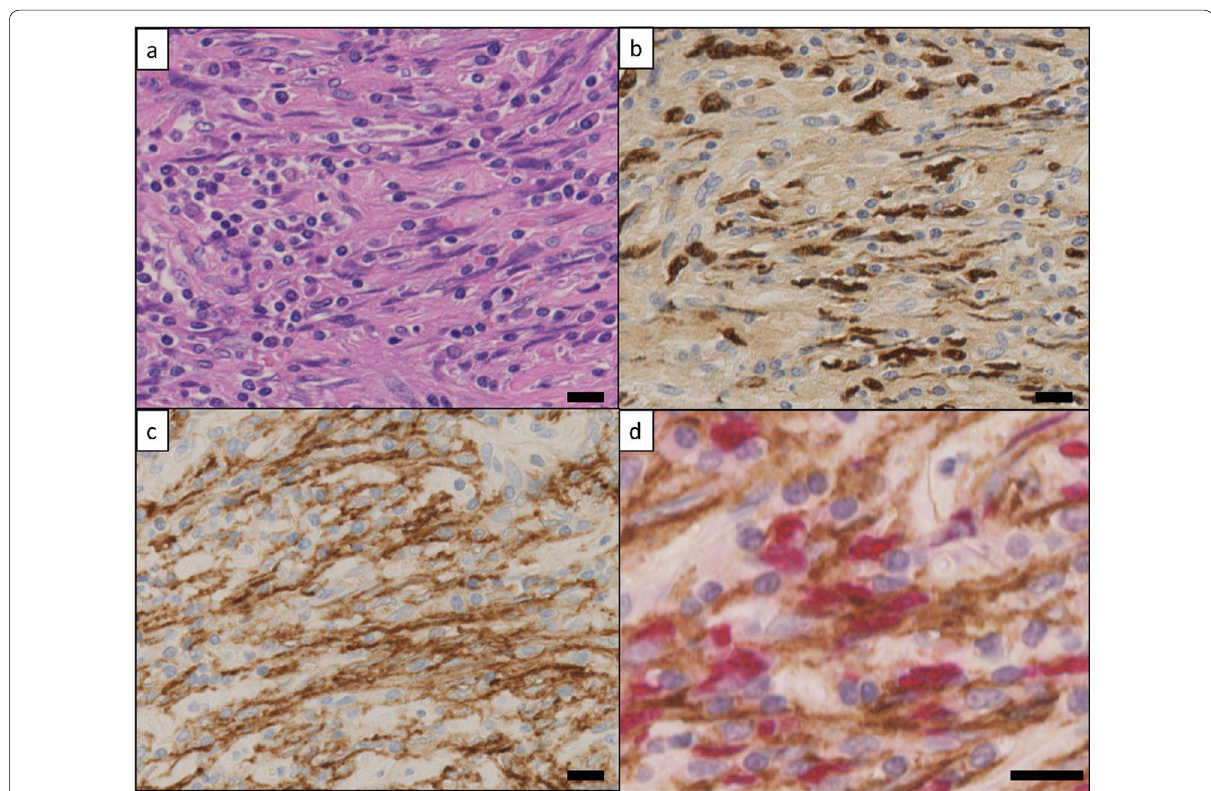
Fig. 3 EBER–ISH and immunohistochemistry for EBV-associated FDCS (scale bars 25 µm). a Lesion is composed of atypical spindle cells admixed = with infiltrating inflammatory cells on hematoxylin and eosin staining. b Nucleus of the spindle cells is diffusely positive for EBER–ISH. c Cytoplasmic positivity for CD23. d Double staining for CD23 immunohistochemistry (brown) and EBER–ISH (red) revealing that EBER–ISH positive cells show CD23 immunoreactive cytoplasm. EBER: Epstein–Barr virus enucleated RNA; ISH: in-situ hybridization; FDCS: follicular dendritic cell